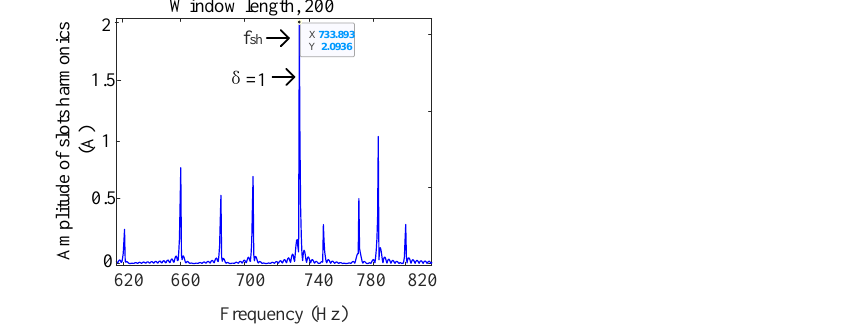
Figure 6. Extracted slot harmonic frequency f sh = 733.89 Hz, speed n = 1465.48 r/min.